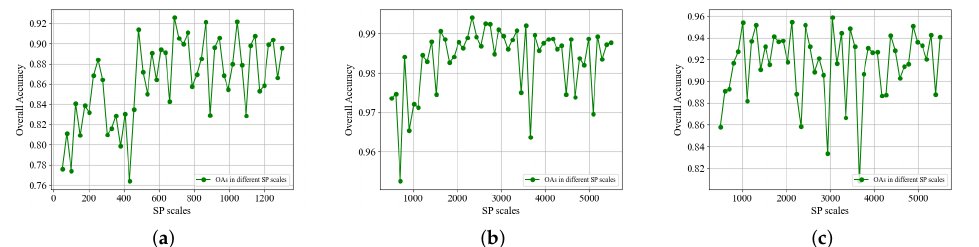
Figure 4. OAs of the SGL in different scales on three HSI datasets. ( a ) Indian Pines. ( b ) Salinas ( c ) University of